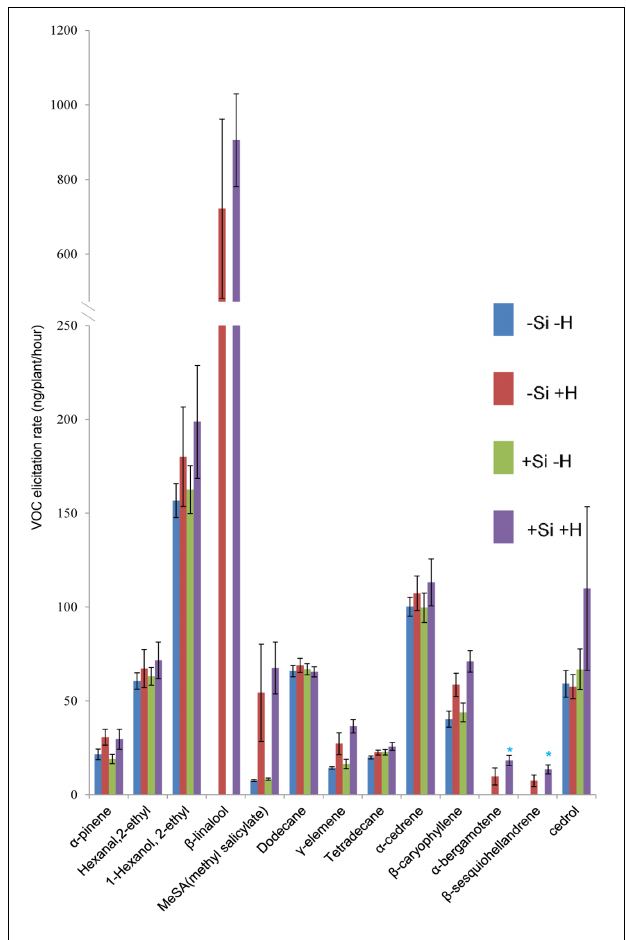
FIGURE 2 | Effect of herbivore (H) ( C. medinalis ) infestation and silicon (Si) treatment on volatile organic compound (VOC) production by OsCOI1 RNAi rice plants. [Mean ± SE; ∗ , significant effect of silicon within herbivore treatment ( P < 0.05) by Fisher’s Least Significant Difference test of one-way analysis of variance